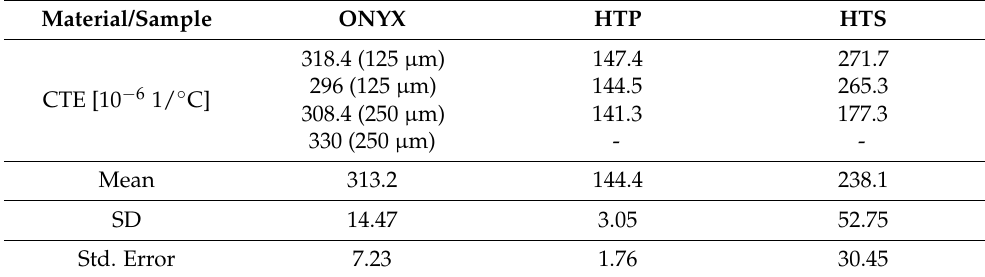
Table 4. Overall TMA statistical data of CTE measurements for ONYX material (over 30 to 160 ◦ temperature range).